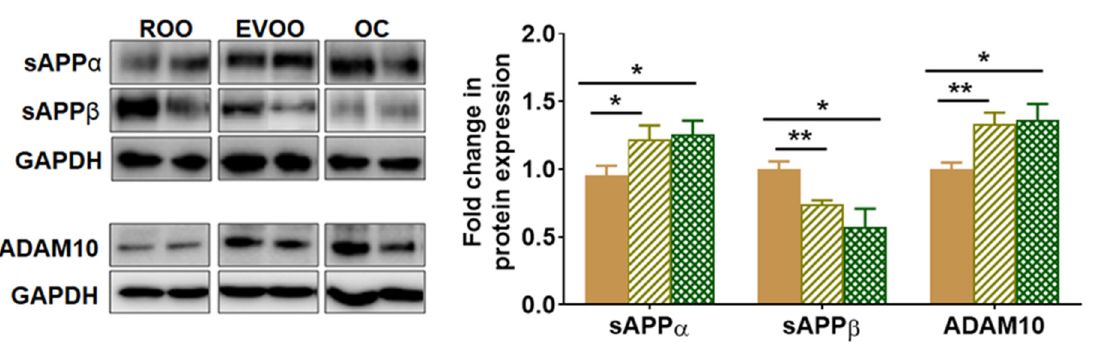
Figure 3. Effect of EVOO and OC consumption (0.5 µ g/kg) for three months on A β production proteins in 5xFAD mouse brains. Representative blots and densitometry analysis of sAPP α , sAPP β , and ADAM10 (n = 6 mice per group). Values were normalized to the ROO group (1.0). Data are presented as mean ± SEM. * p < 0.05, ** p < 0.01 compared to ROO.